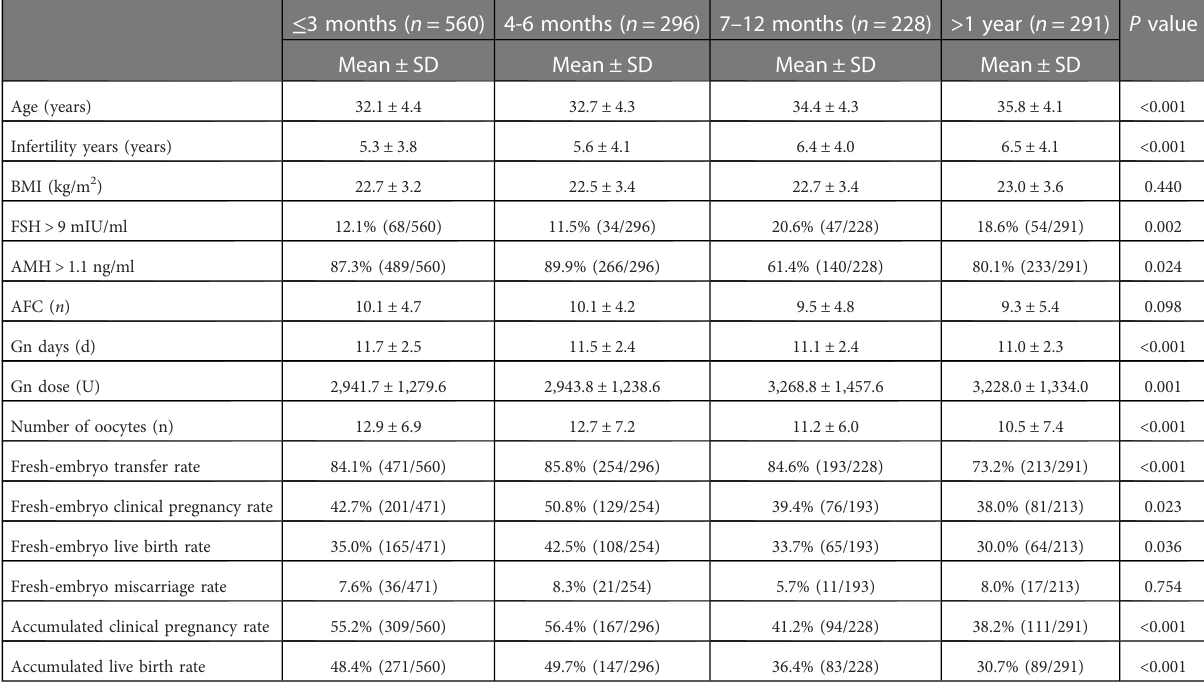
TABLE 3 Oocyte retrieval initiated at different time after laparoscopic surgery.